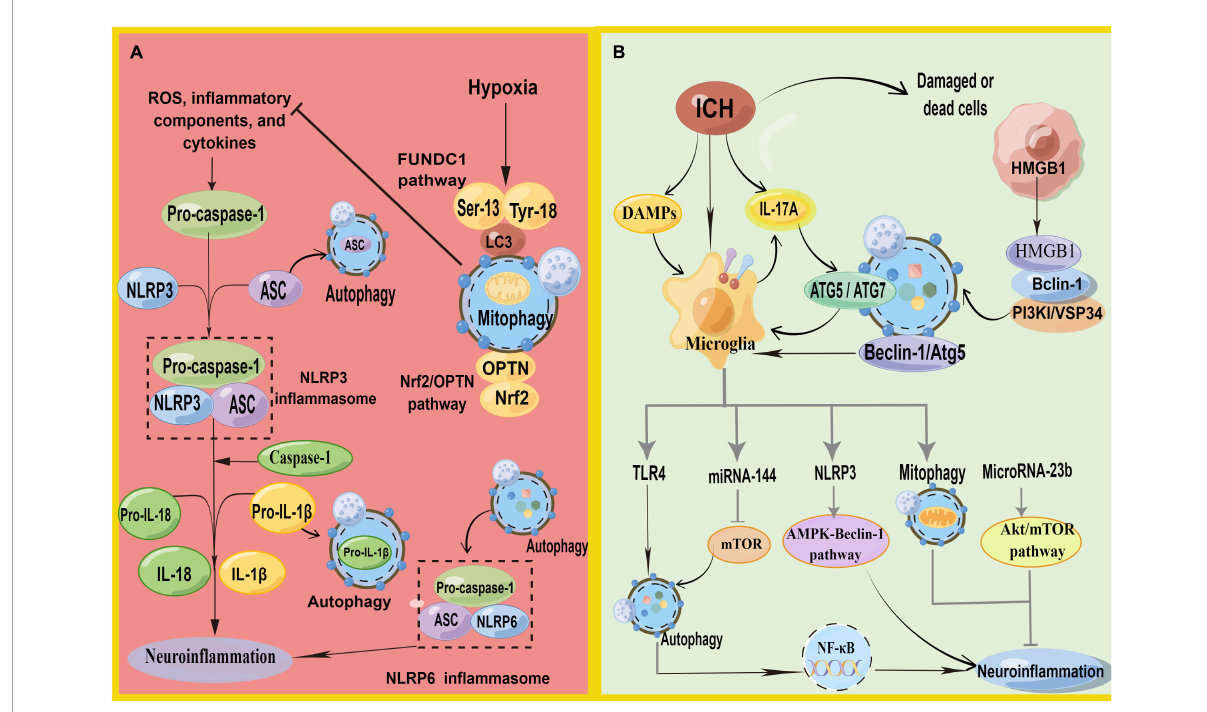
FIGURE4 (A) Schematic illustration of autophagy regulates NLRP3 inflammasome and NLRP6 inflammasome. NLRP3, pro-caspase-1, and ASC aggregate to form NLRP3 inflammasome. Autophagy antagonizes inflammation mainly in three parts: (1) P62 can recognize ubiquitinated ASC and induce autophagy to degrade inflammasome adaptor protein ASC selectively. (2) Decomposition and removal of pro-IL-1 β , the substrate of inflammatory mediators. (3) Can inhibit NLRP3 inflammasome activation by removing endogenous inflammasome activators, such as ROS. Meanwhile, mitophagy antagonizes neuroinflammation-mediated NLRP3 inflammasome via FUNDC1 and Nrf2/OPTN pathways. In addition, autophagy promotes inflammasome-dependent NLRP6-mediated inflammation after ICH. (B) Schematic illustration of autophagy in